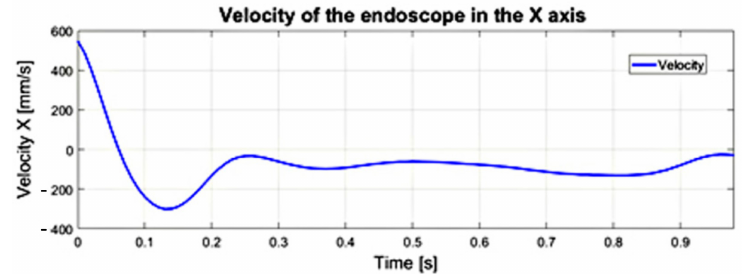
Figure 17. Velocity course of the endoscopic tool along the X − axes obtained on the basis of the